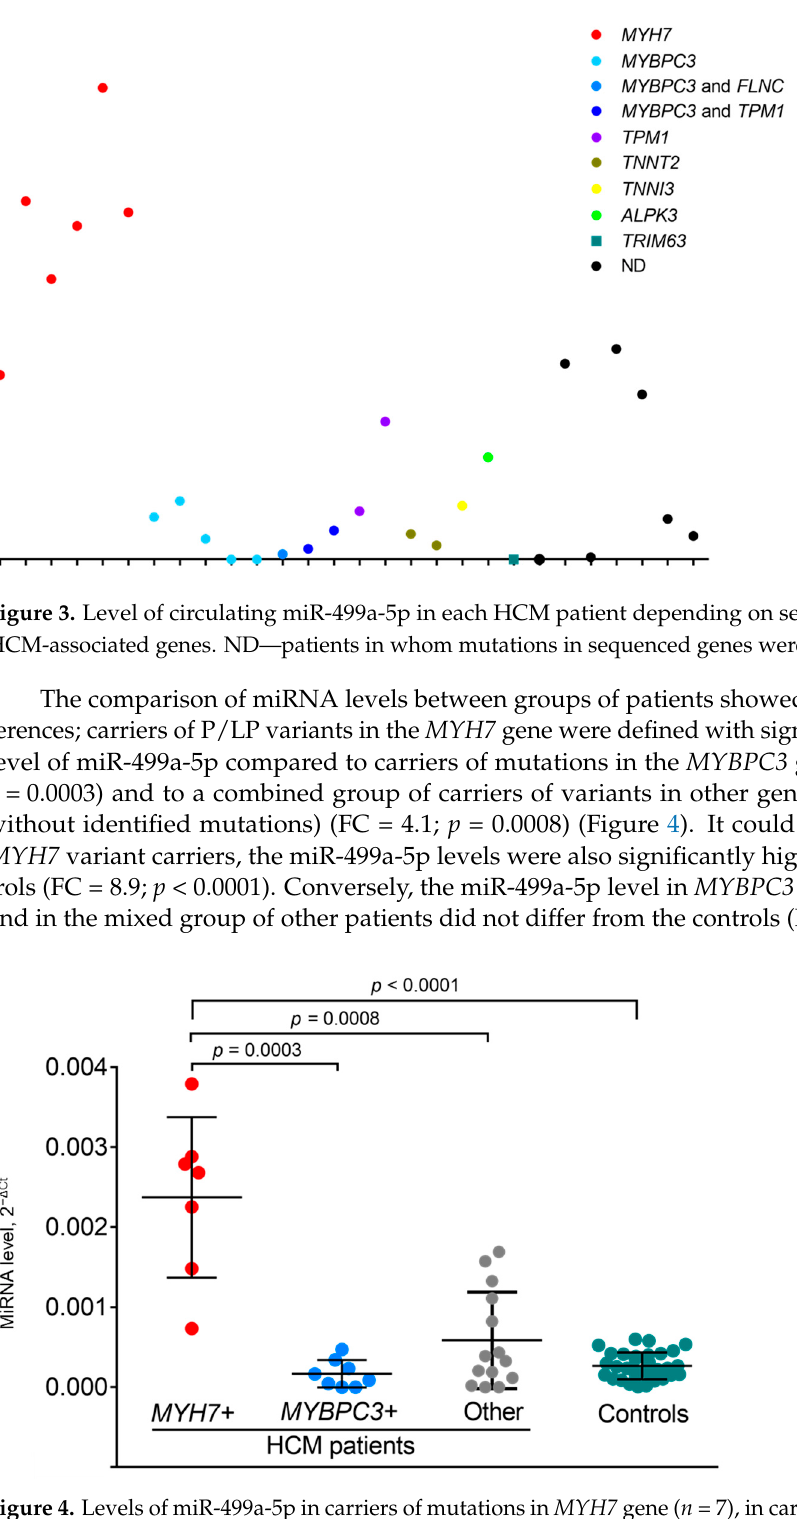
Figure 5. The ROC curve analysis of circulating miR-499a-5p for detecting MYH7 -positive HCM patients. ROC—receiver operating characteristic; AUC—area under the curve. 3. Discussion In our study, high throughput sequencing of circulating miRNAs in HCM patients and individuals without cardiovascular diseases pinpointed miR-499a-5p as one of the dysregulated miRNAs in HCM. Further investigation involving representative groups showed that miR-499a-5p levels are significantly higher in carriers of P/LP variants in the MYH7 gene than in controls. The mismatch in the direction of changes in miRNA levels according to discovery RNA-seq profiling and validation RT-qPCR data may be due to